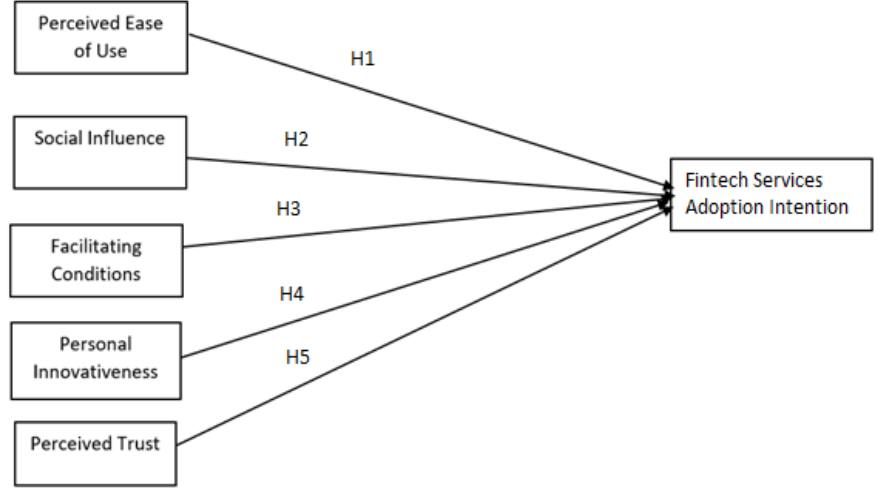
Figure 1. Research framework